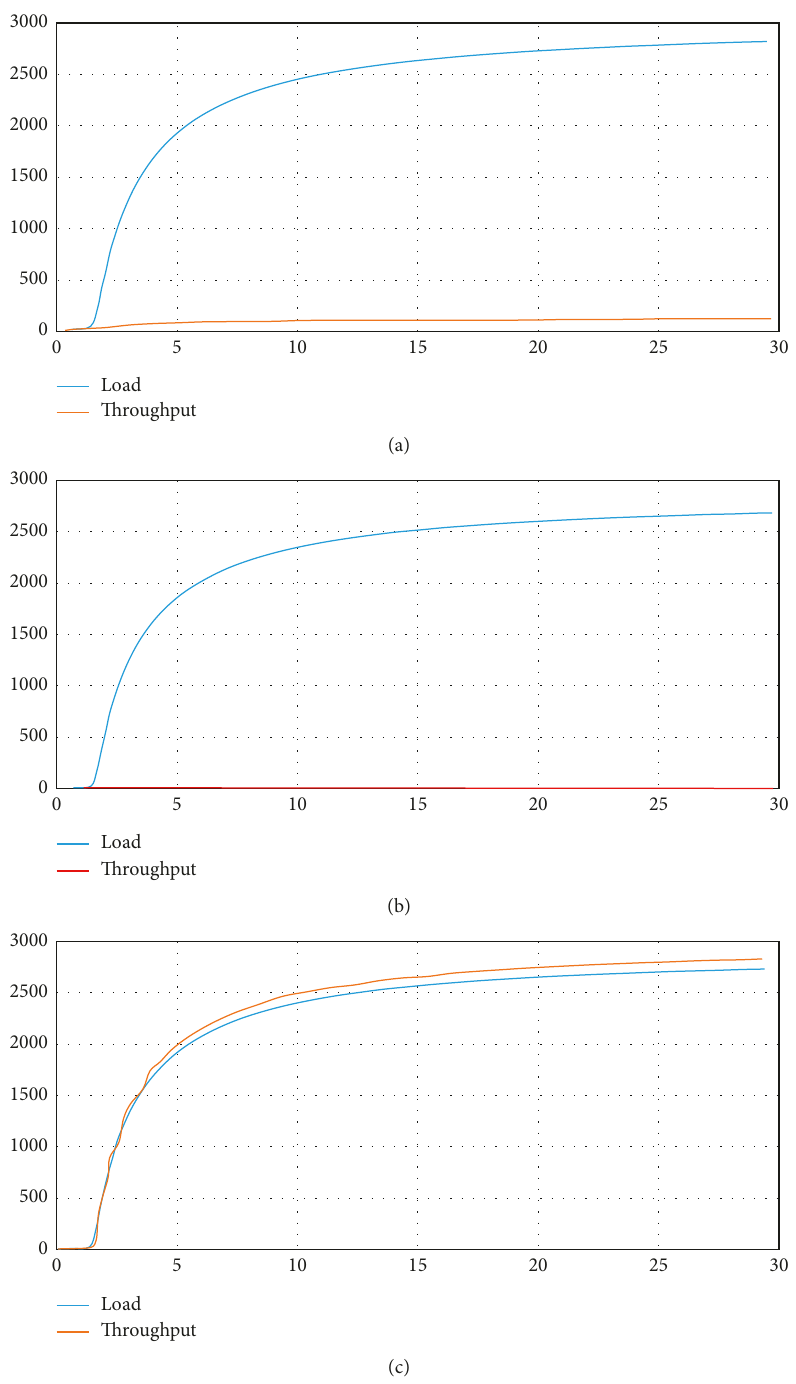
Figure 6: (a) Unicast (load versus throughput). (b) Multicast (load versus throughput). (c) Hybrid (load versus